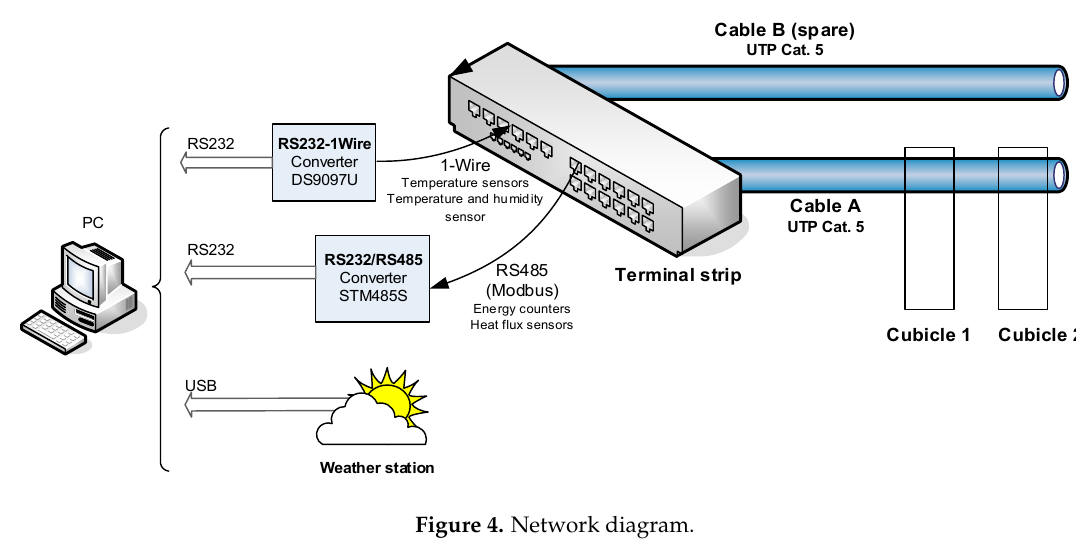
Figure 4. Network diagram.